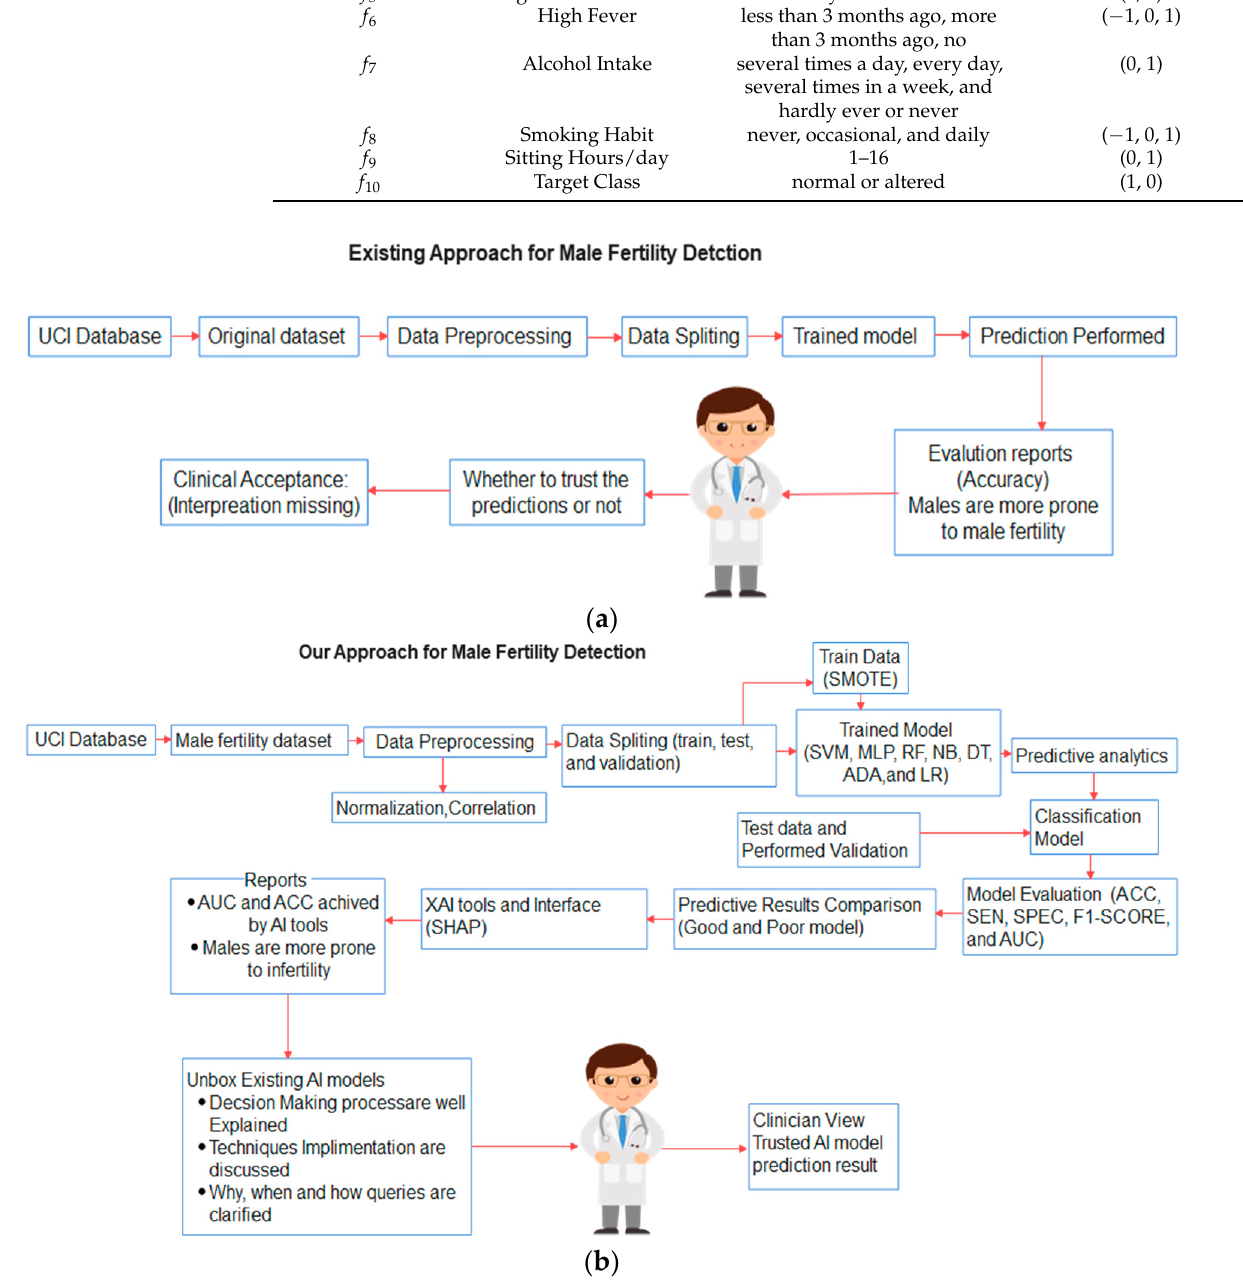
Figure 1. ( a ) ML approach without XAI. ( b ) ML approach with XAI.